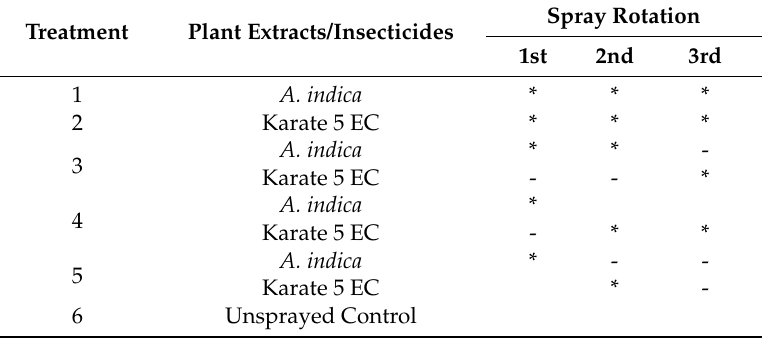
Table 2. Details of different treatments used in the